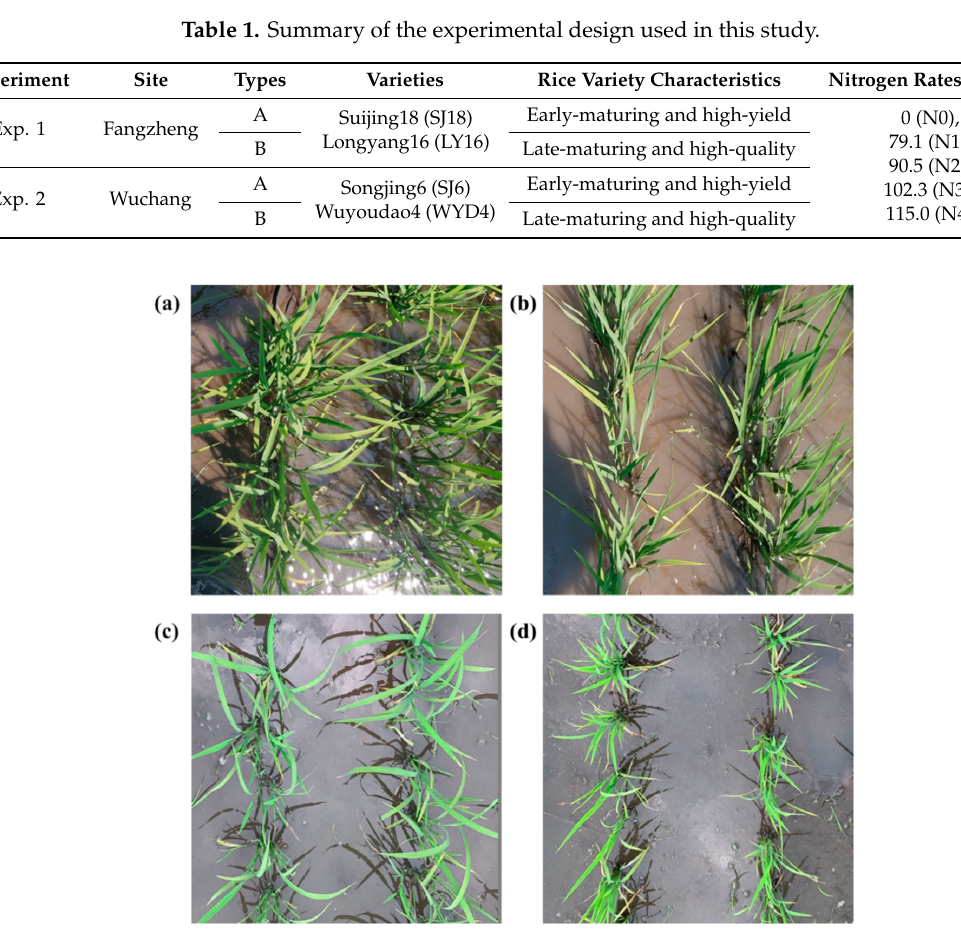
Figure 1. Canopy images of different varieties of rice at the tillering stage: ( a ) SJ18, ( b ) LY16, ( c ) SJ6 and ( d )